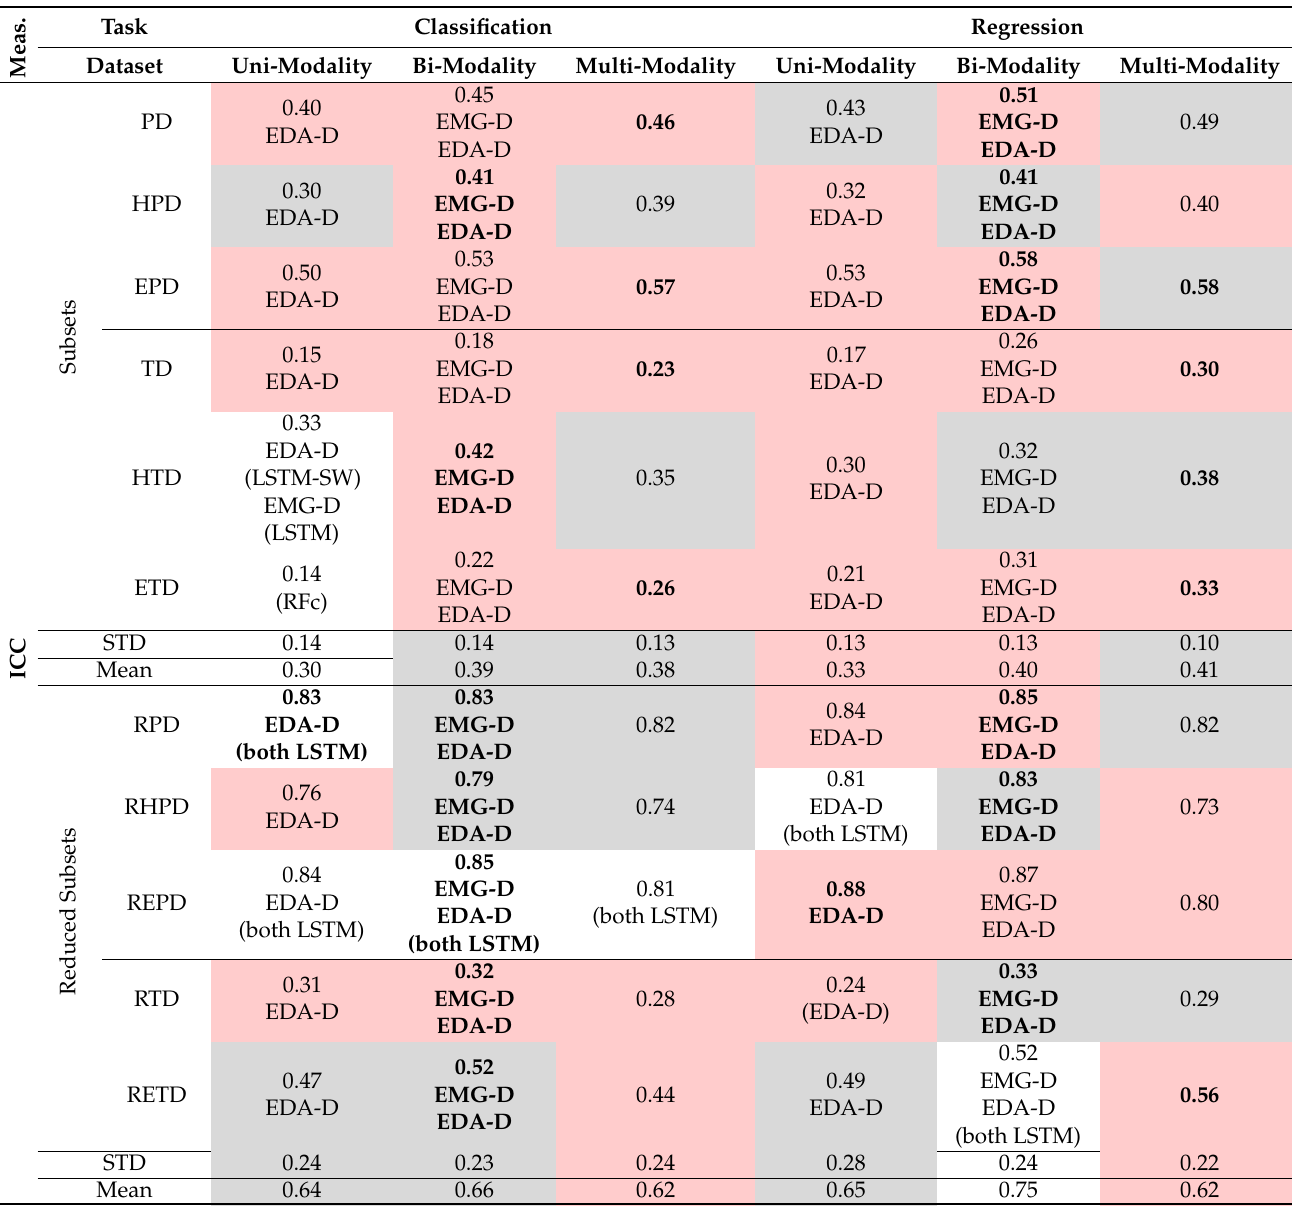
Table 7. Comparison of the best Uni-, Bi-, and Multi-modality models regarding classification and regression tasks with ICC measure. Meas.: Measure. The cells with light grey background indicate the models using LSTM, and cells with pink background indicate the models using LSTM-SW. The bold font indicates the best